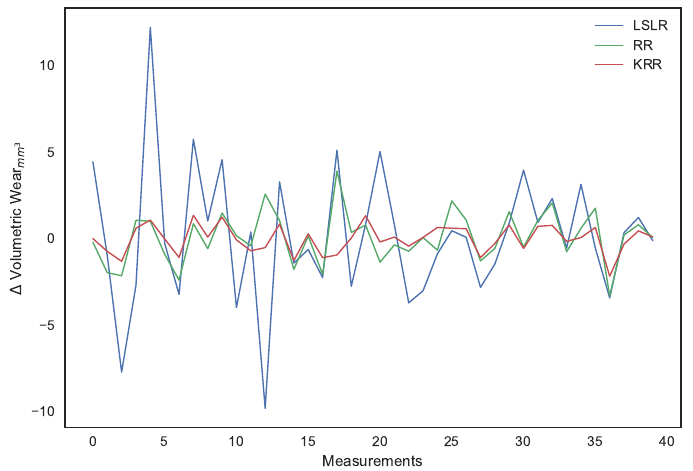
Figure 16. Deviation between model predictions and actual surface wear.